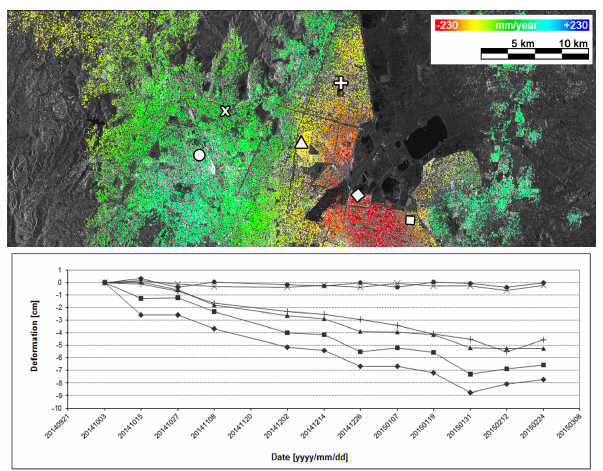
Figure 3. Deformation map (top panel) of the processed burst en- compassing a large area of Mexico DF superimposed over a SAR amplitude image, and six examples of time series of deformation (bottom panel) from the same